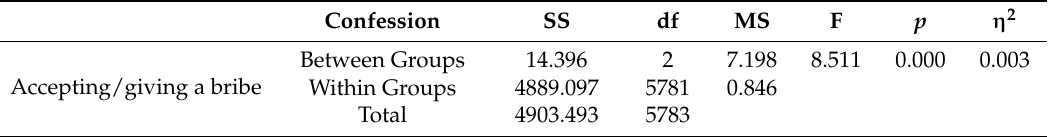
Table A6. Accepting/giving a bribe among confessions.